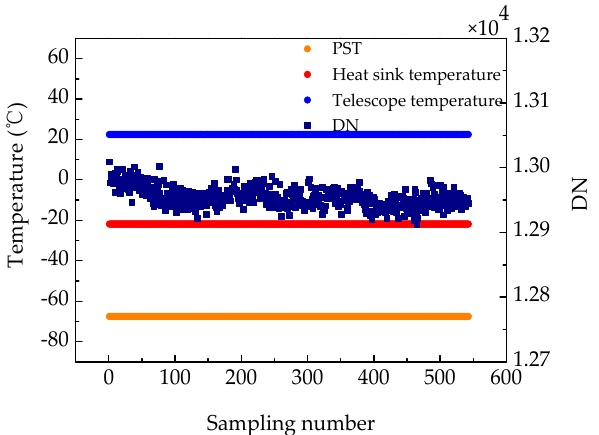
Figure 10. Results of the instrument-level stability experiment. The DN fluctuated by approximately 0.75%, and the temperatures of the heat sink, photosensitive surface, and the turning optical path were stable.